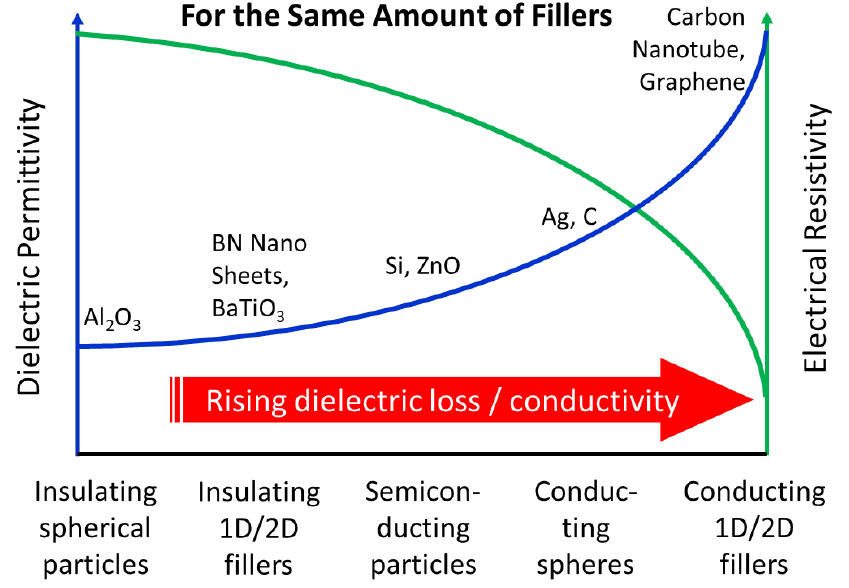
Figure 1. The schematic trend of dielectric response and electric resistivity with increasing the electric conductivity and aspect ratios of the fillers.